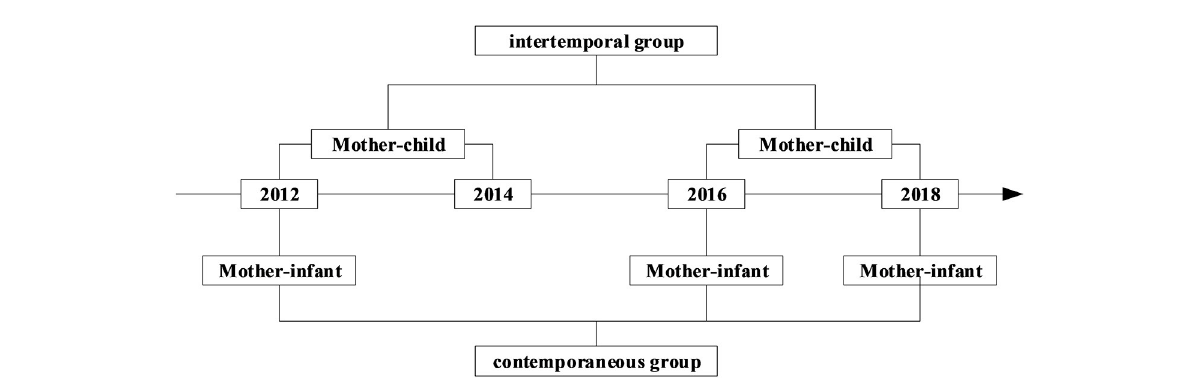
FIGURE1 Flow chart of the study groups. The intertemporal group consisted of mothers from 2012 and 2016 who were matched with children from 2014 and 2018, respectively. The contemporaneous group consisted of mother–infant pairs from 2012, 2016, and 2018.